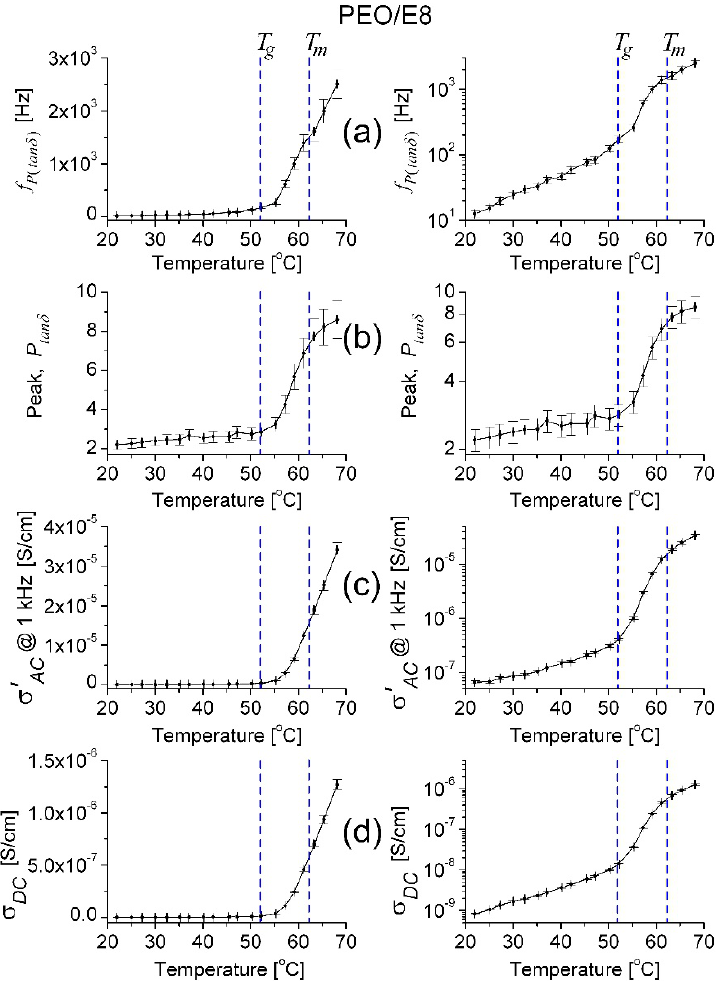
Figure 12. Temperature dependence of the peak frequency f P ( tanδ ) ( a ) , and the peak values P tanδ ( b ) and σ (cid:48) at f = 1 kHz ( c ) , determined for PEO/E8 composite, in linear ( left ) and logarithmic ( right ) scale. The temperature dependence of ion conductivity (σ) for PEO/E8 is given for comparison ( d ). The dashed lines point out the values of glass transition temperatures ( T g ) for both composites. The error bars indicate the uncertainty of the calculated values.